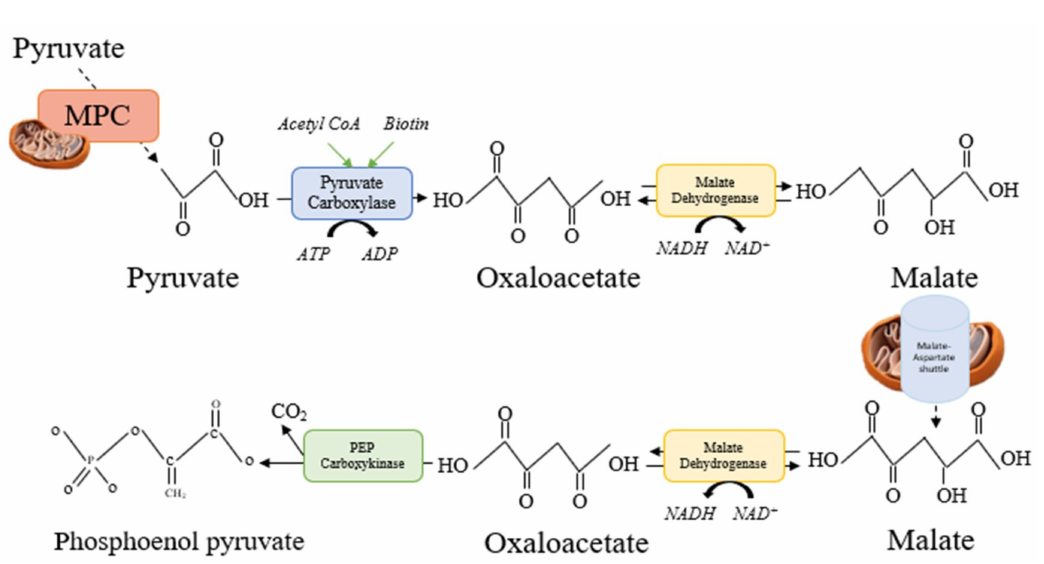
Figure 3. Graphical overview of the role of Malate in part of the gluconeogenic process. NADPH = Nicotinamide adenine dinucleotide binding domain. H = Hydrogen. O = Oxygen. MPC = mitochondrial pyruvate carrier. ATP = Adenosine triphosphate. ADP = Adenosine diphosphate. C =